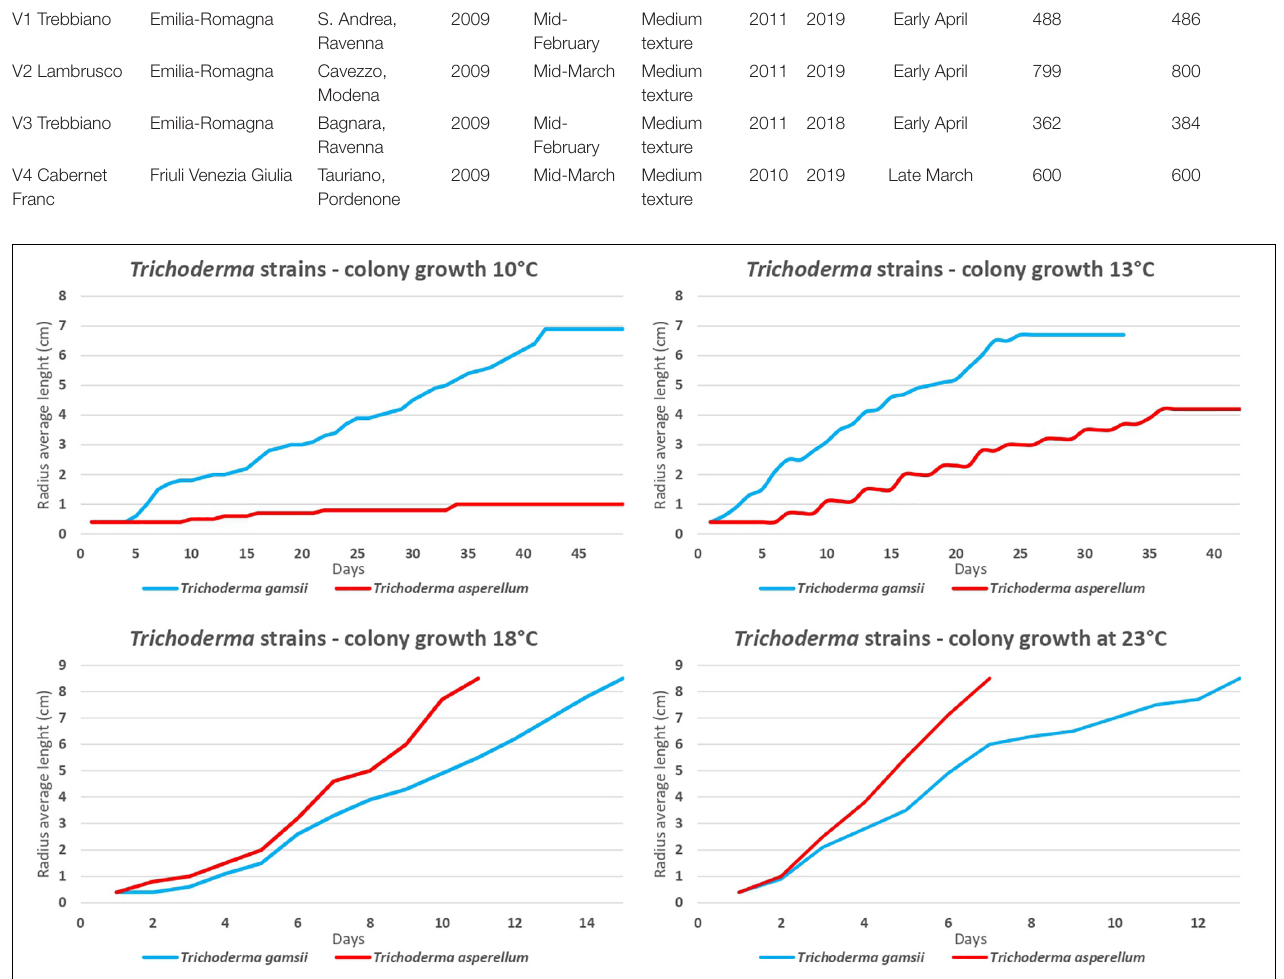
FIGURE 2 | Trichoderma asperellum strain ICC 012 ( Tasp ) and T. gamsii strain ICC 080 ( Tgam ) growth at 10, 13, 18, and 23 ◦ C on marine agar.